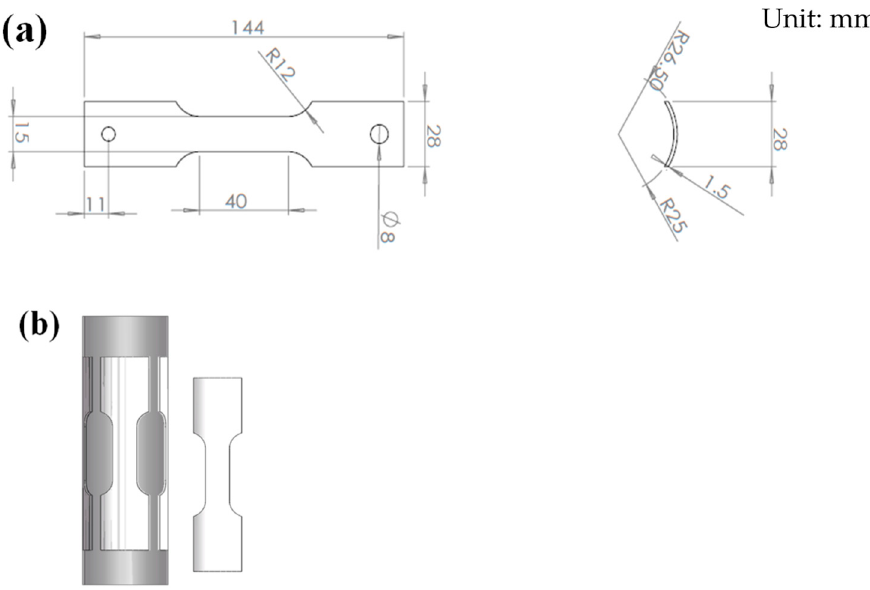
Figure 2. Tensile specimen size and sampling schematic diagram of the irradiation channel tube: ( a ) tensile specimen size; ( b ) sampling schematic diagram.